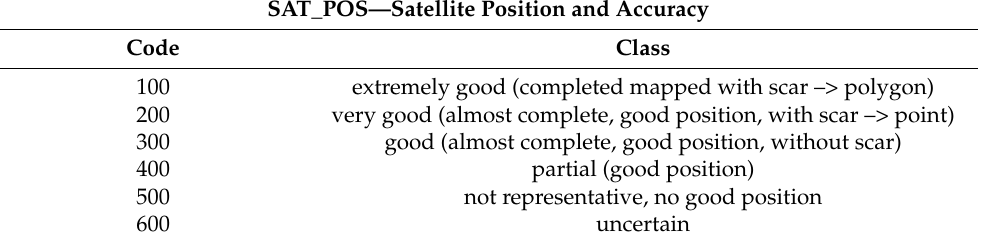
Table 5. ASTER position